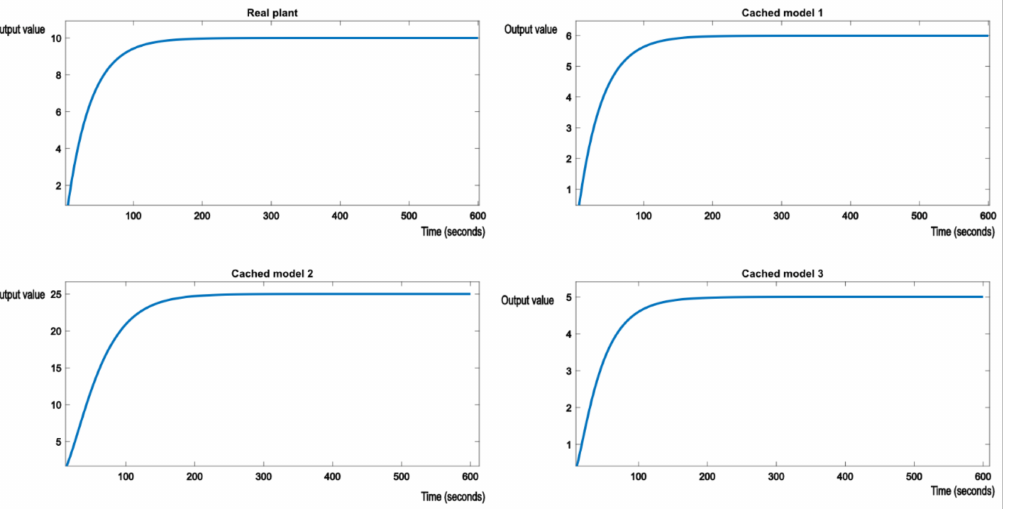
Figure 6. Initial evolution of the real process and the nominal models in the knowledge